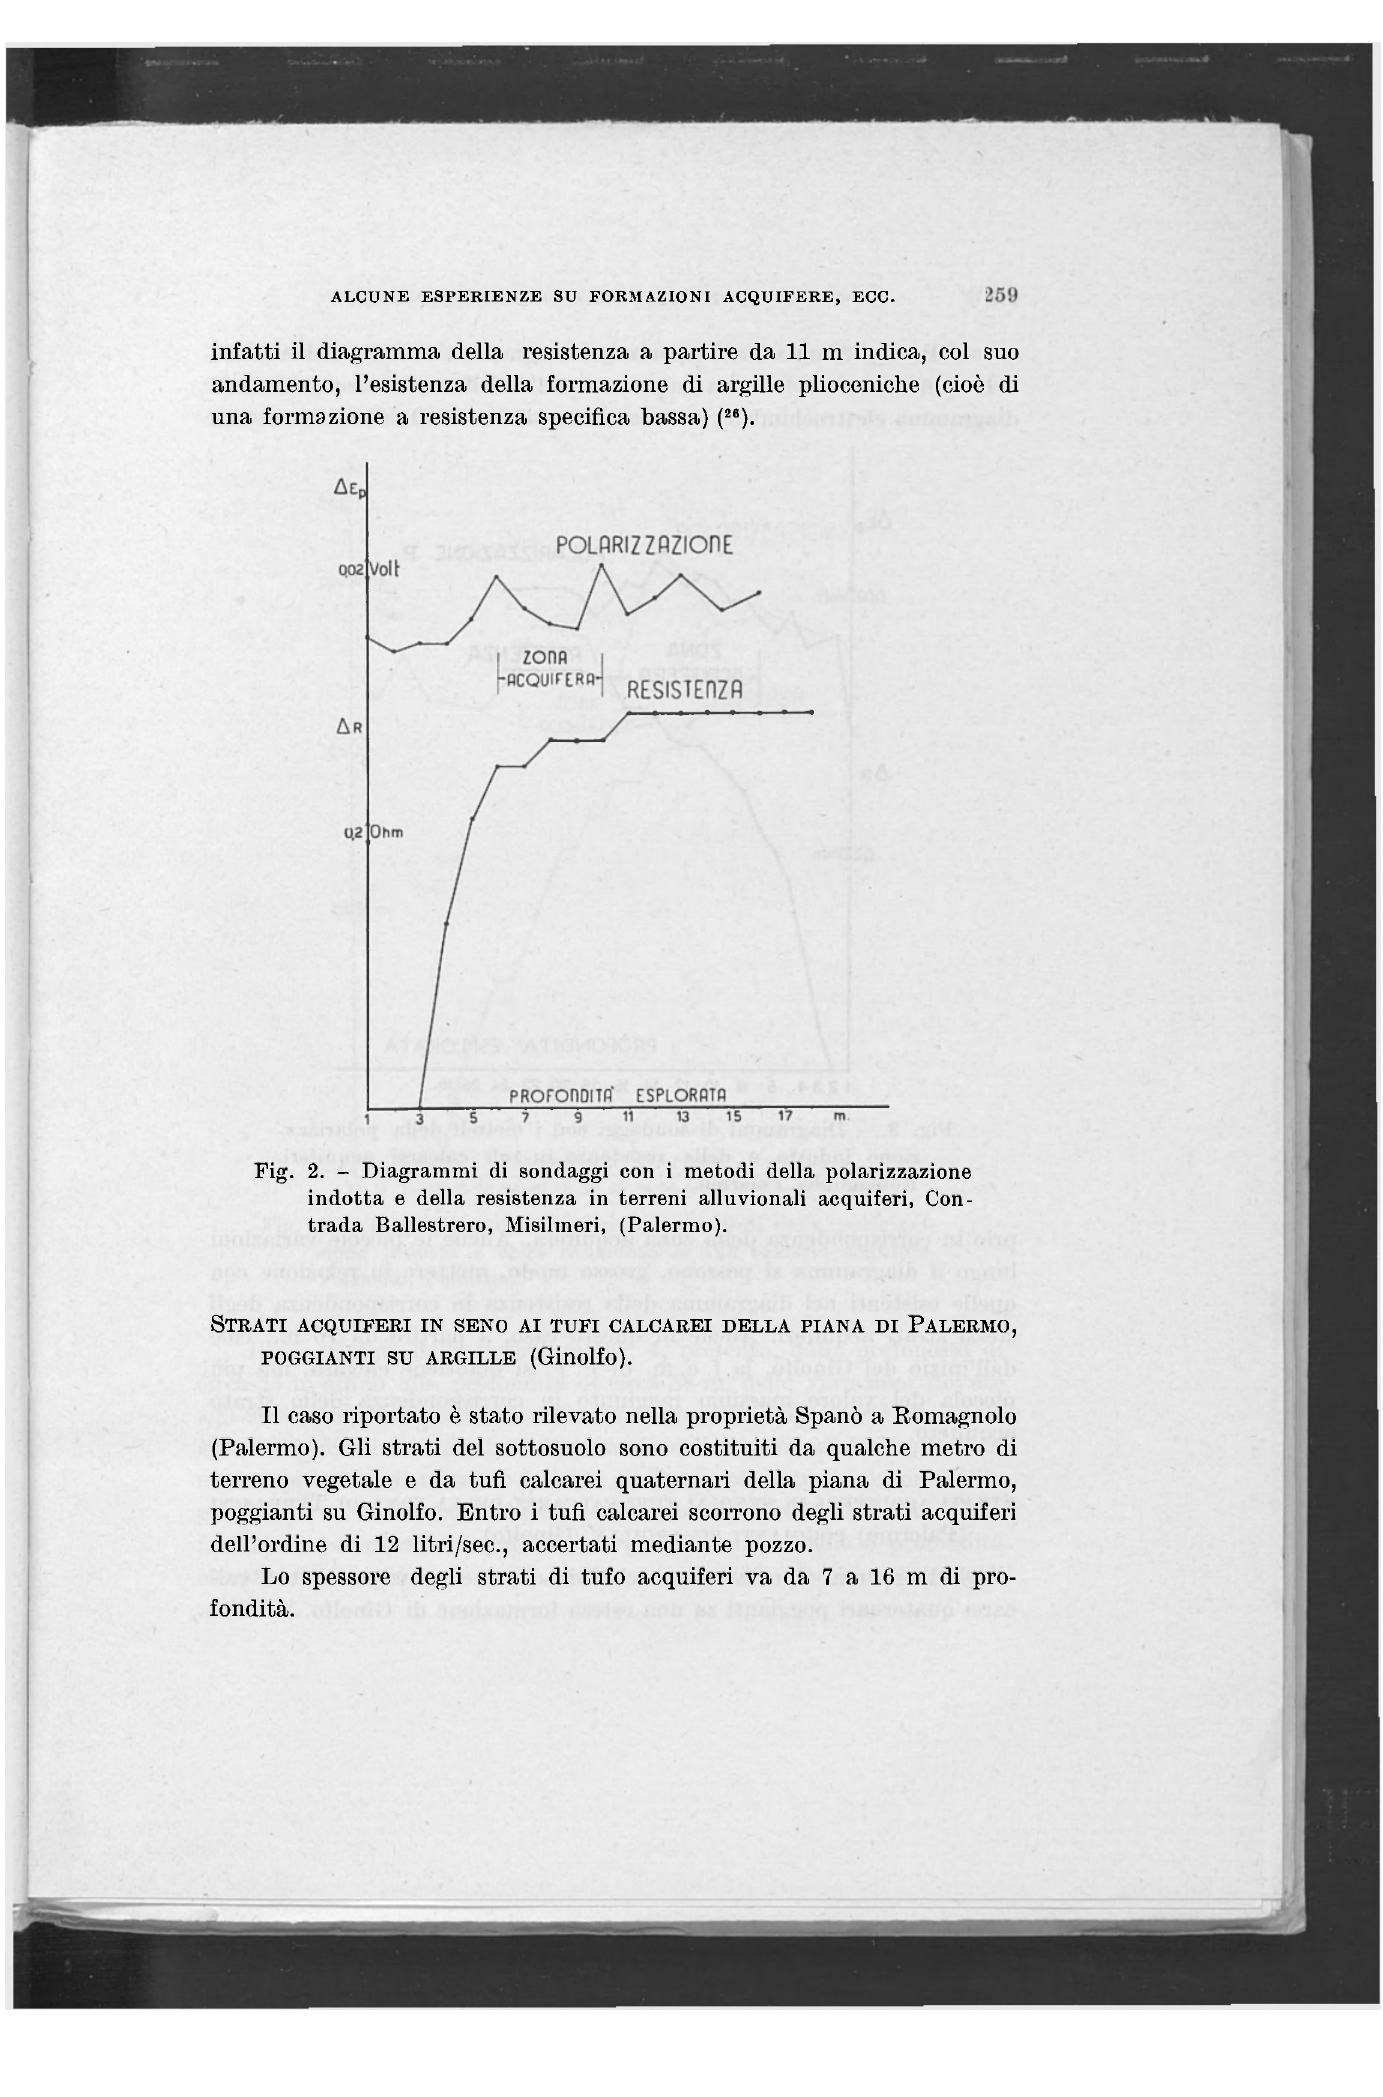
Fig. 2. - Diagrammi di sondaggi con i metodi della polarizzazione indotta e della resistenza in terreni alluvionali acquiferi, Con- trada Ballestrero, Misihneri,